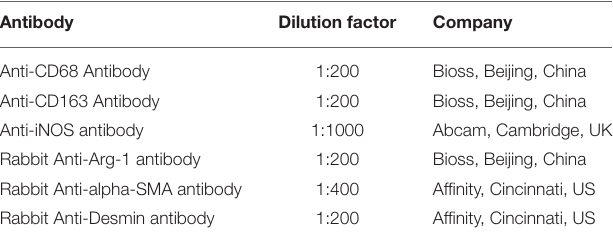
TABLE 3 | Antibodies used for immunohistochemistry.